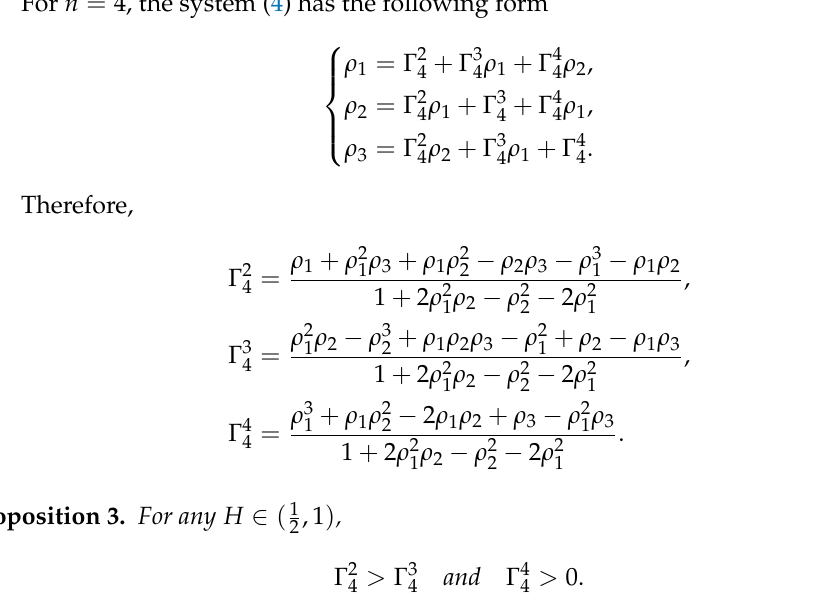
and Γ 3 as the functions of H 3 3